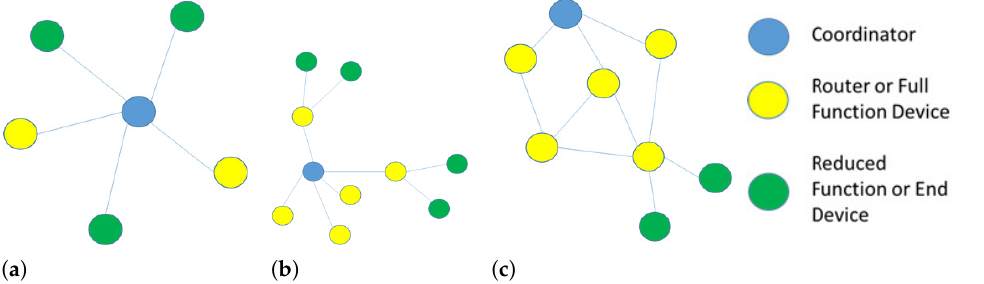
Figure 1. Different ZigBee network topologies ( a ) star, ( b ) cluster tree and ( c ) mesh.